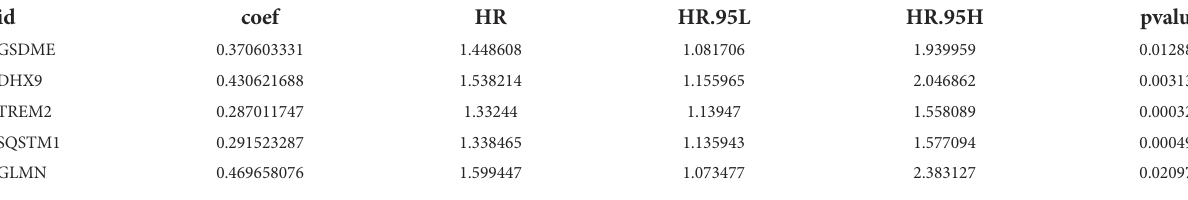
TABLE 1 Multivariate Cox regression analysis to screen out the key RBPs most relevant to prognosis.